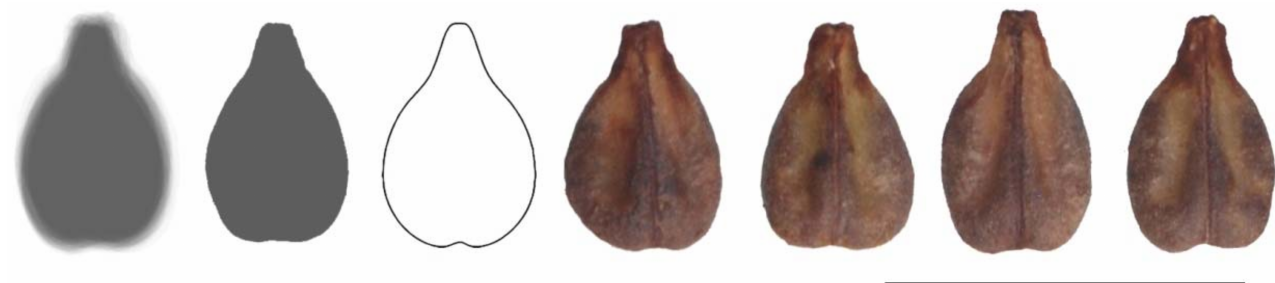
Figure 10. Heb é n Model. From left to right: A sum of the silhouettes of 30 seeds, a silhouette obtained by the pixel profile of the first image, the Heb é n model, and four representative seeds of this cultivar. Bar represents 1